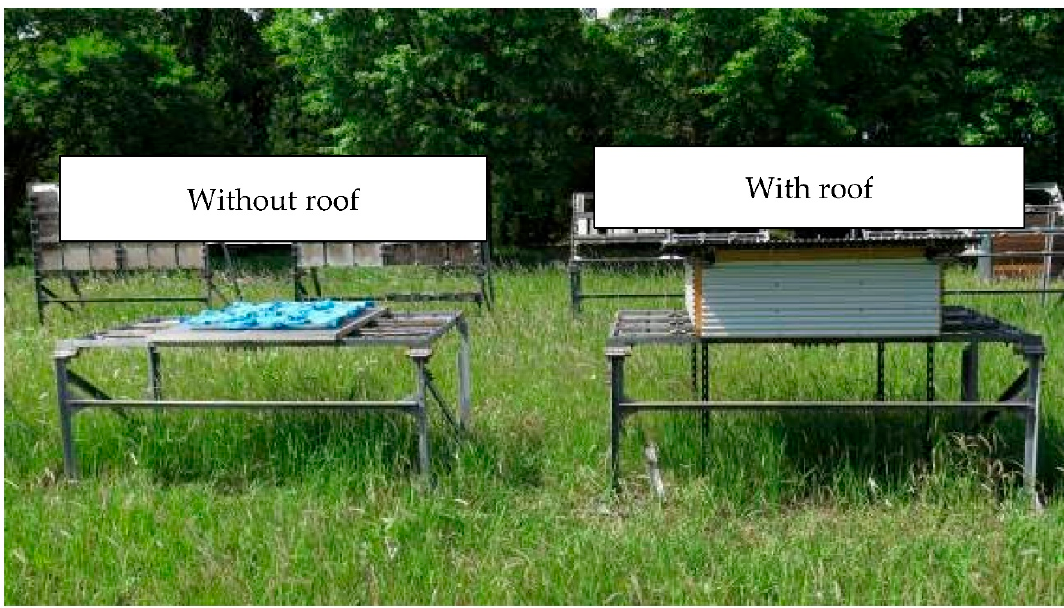
Figure 1. Overview of outdoor weathering test.